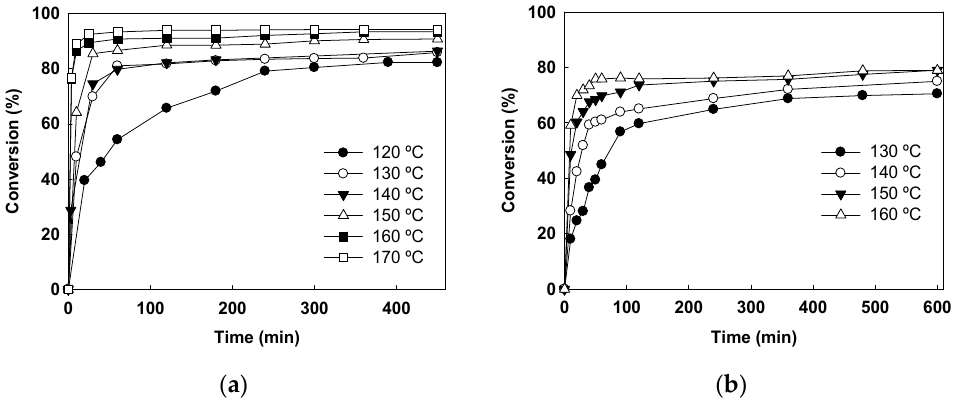
Figure 9. Effect of temperature. Reaction conditions: 1% Ti(IV) isopropoxide and HE:ME molar ratio of ( a ) 2:1 and ( b ) 1:1.